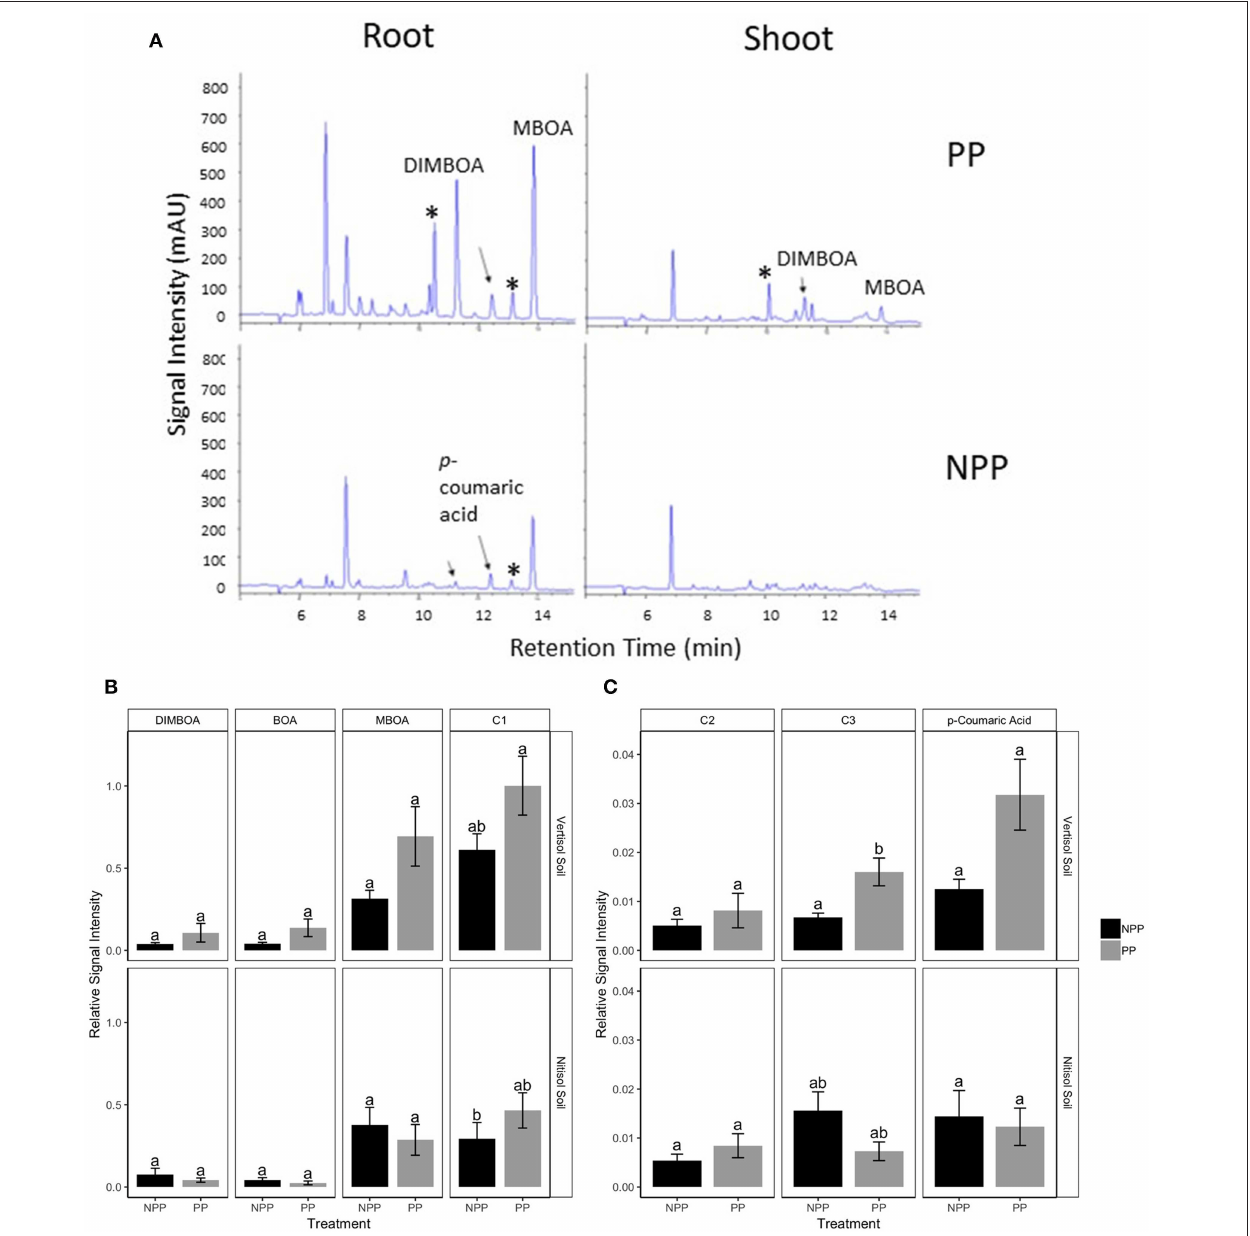
FIGURE 5 | Non-volatile secondary metabolites produced by maize plants grown in soil obtained from Push-Pull (PP) companion cropping and Non-Push-Pull (NPP) monoculture fields: (A) Representative High Performance Liquid Chromatography profiles of non-volatile secondary metabolites from Root and Shoot tissue. (B) Mean ( ± SEM) quantities of identified benzoxazinoids from root tissue per plant from maize plants grown in soil from PP and NPP fields. (C) Mean ( ± SEM) quantities of hydroxycinnamic acids from root tissue per plant from maize plants grown in soil from PP and NPP fields. Overall mean abundance of known maize defense metabolites was significantly higher in maize grown in soil conditioned by Push-Pull cropping compared to Non-Push-Pull monocultures ( P ≤ 0.001). * indicates benzoxazinoid metabolites whose identity has not yet been confirmed using authentic synthetic standards. C1, C2, and C3 represent compounds whose identity was not confirmed with authentic standards. Different letters above the bars indicate a significant difference between the means ( P < 0.05) of compound production across soil types and cropping